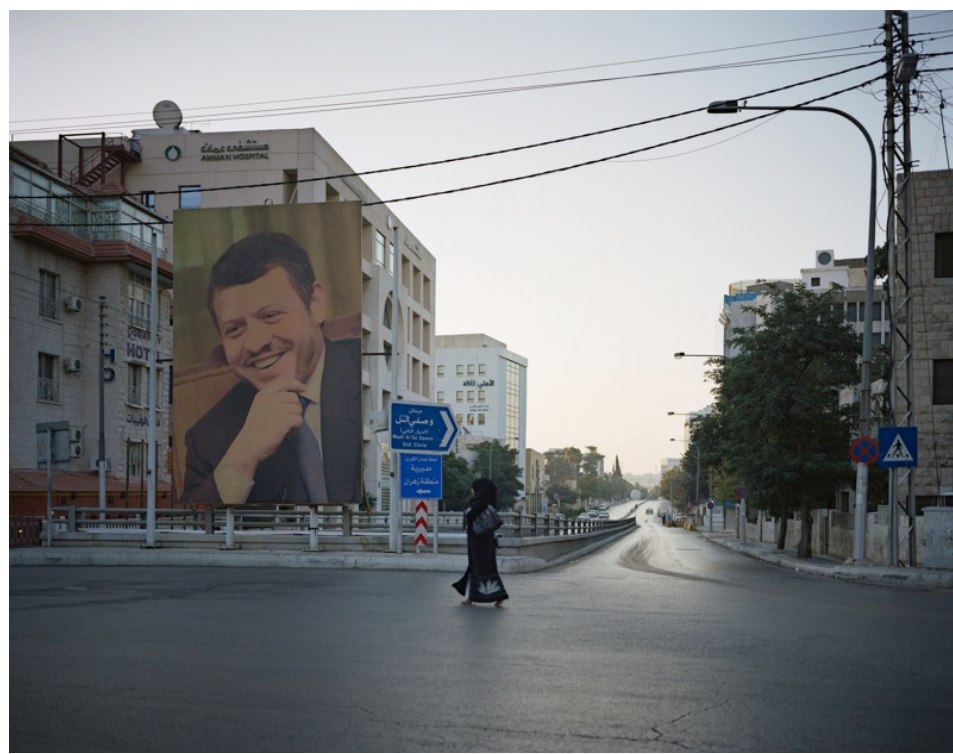
Regina Mamou, Untitled (Third Circle) from the series Mapping Collected Memory , 2009-2010. Digital C-print, 40 x 50 in. (101.60 x 127